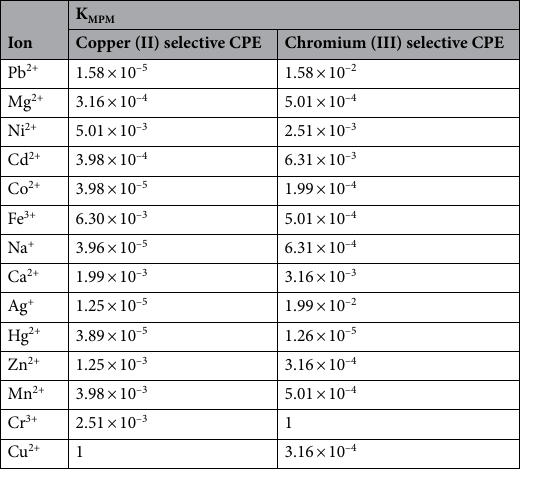
Table 2. The selectivity coefficients of different interfering cations for copper (II) and chromium (III) selective CPEs.